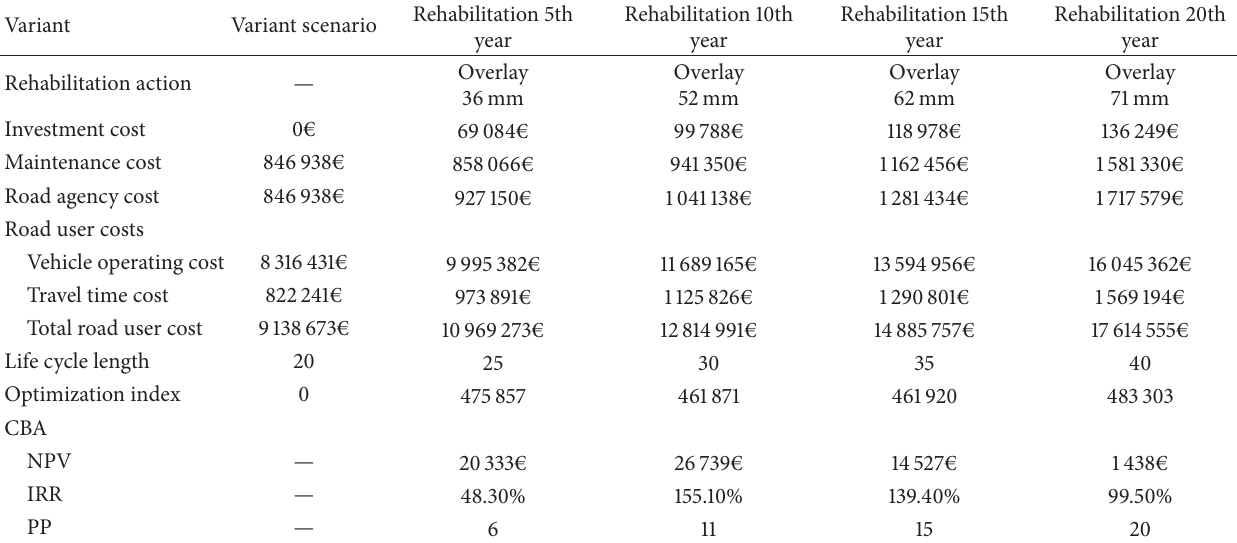
Table 6: The results of the rehabilitation, maintenance, and user